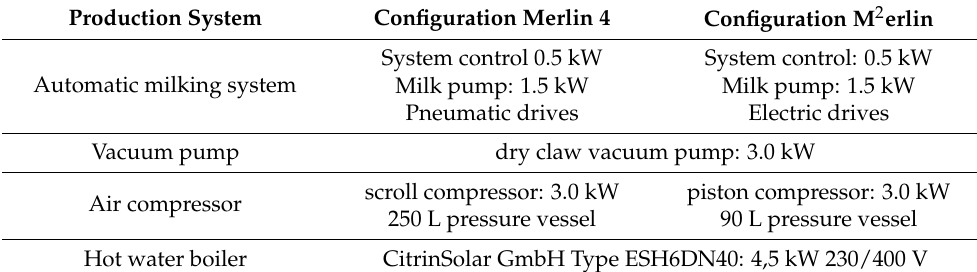
Table 1. Technical and energetic characteristics of the considered energy consumers of the different AMS